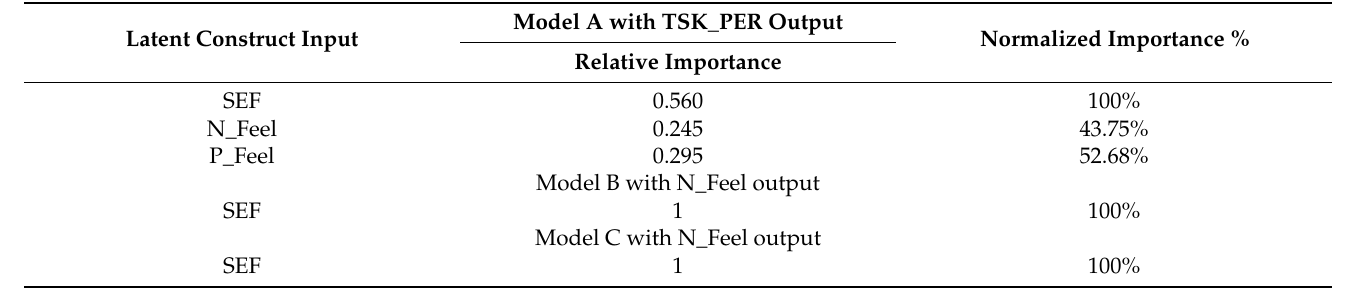
Table 13. Relative Independent Variable